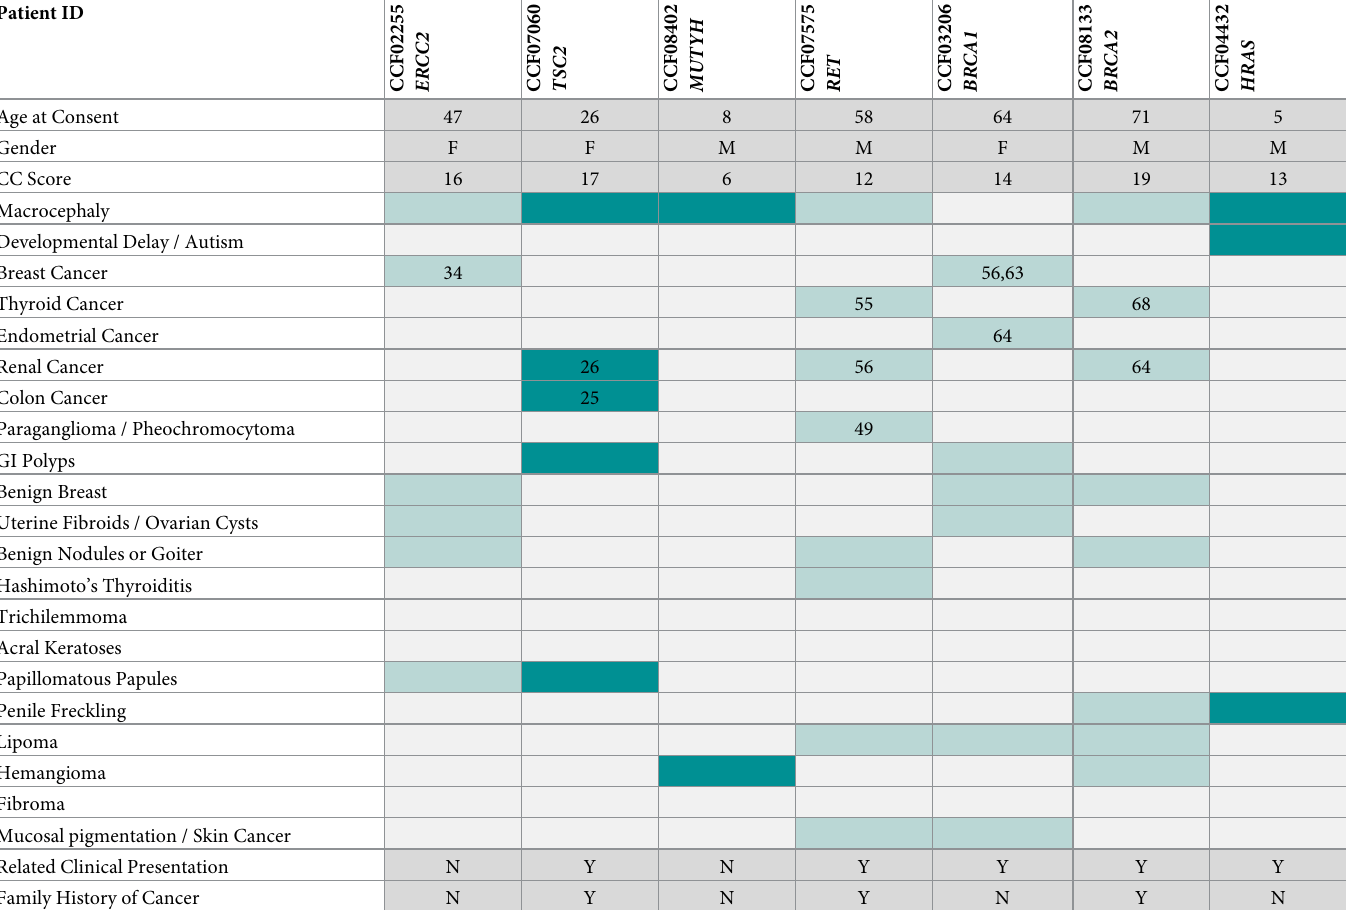
Table 3. Clinicopathological characteristics of patients with identified germline